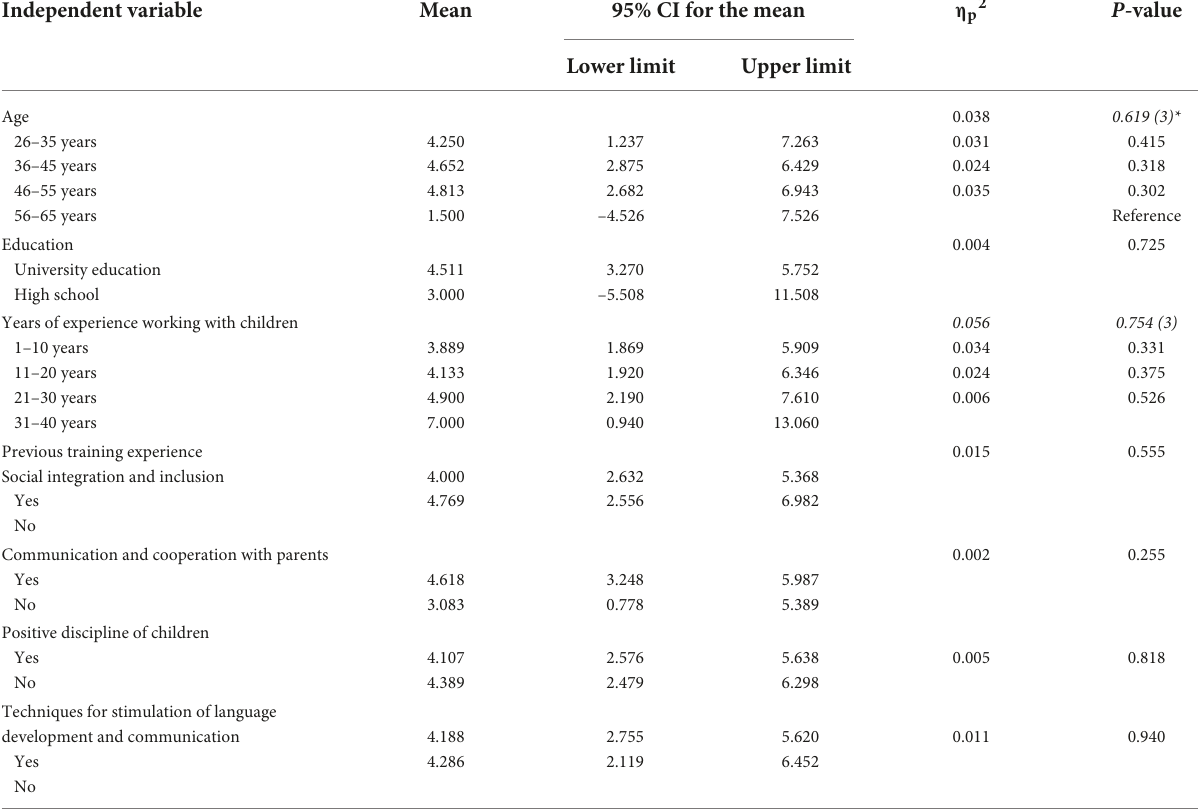
TABLE 4 The impact of training on overall motivation for work scores: Mean values of pre-post-test differences in the general linear model. Independent